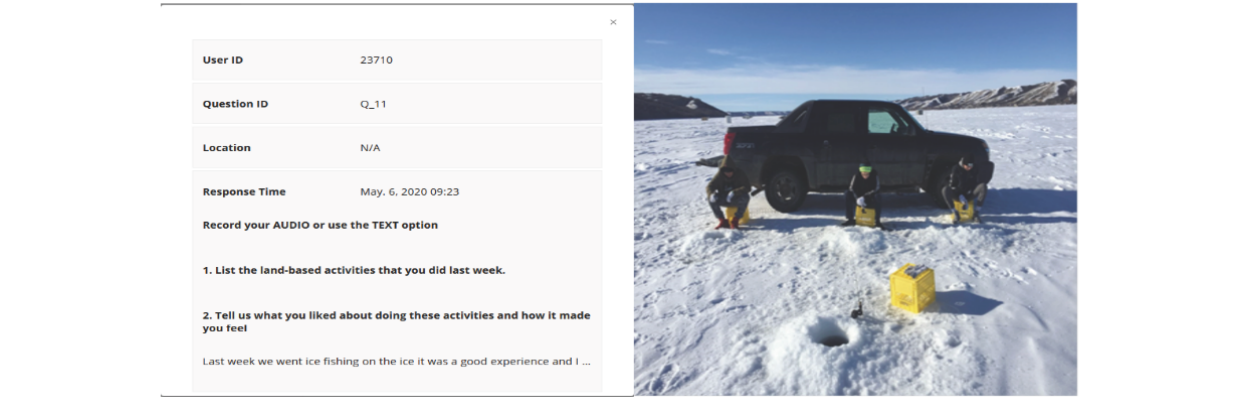
Figure 5. Ecological momentary assessments enabling citizen reporting of culturally appropriate land-based